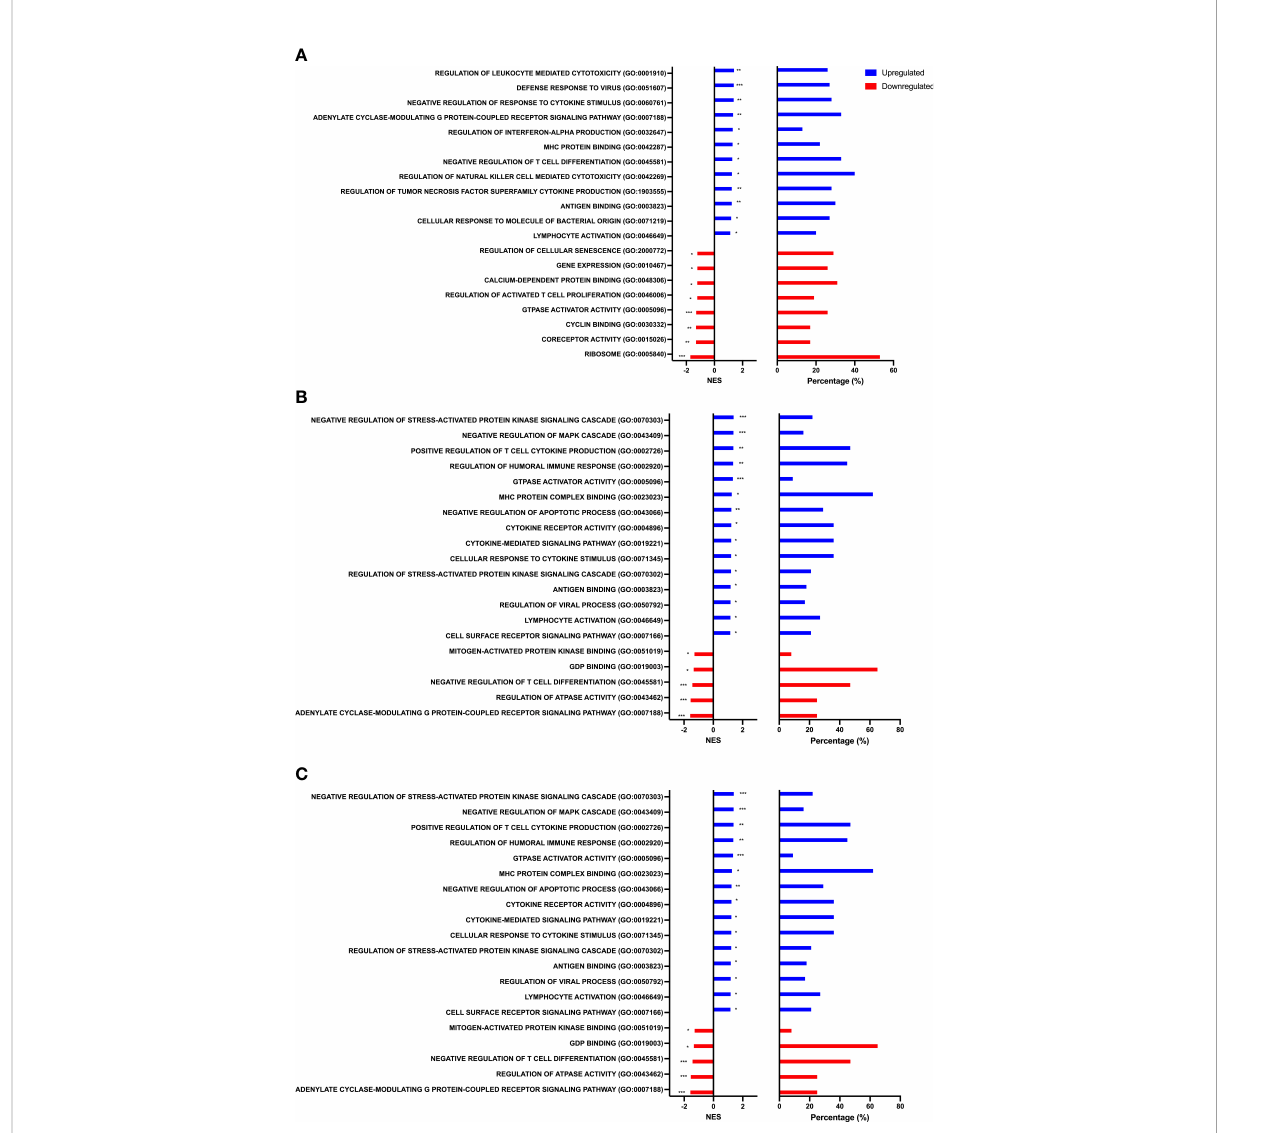
FIGURE 3 Gene set enrichment analysis performed using GO terms. Graphs show enriched upregulated (blue) and downregulated (red) pathways as well as the percentage of DEGs contributing to each mechanism between (A) Rest vs 80% (B) 80% vs . +1H, and (C) Rest vs +1H. Signi fi cance is indicated by * ( p < 0.25), ** ( p < 0.10), *** ( p <